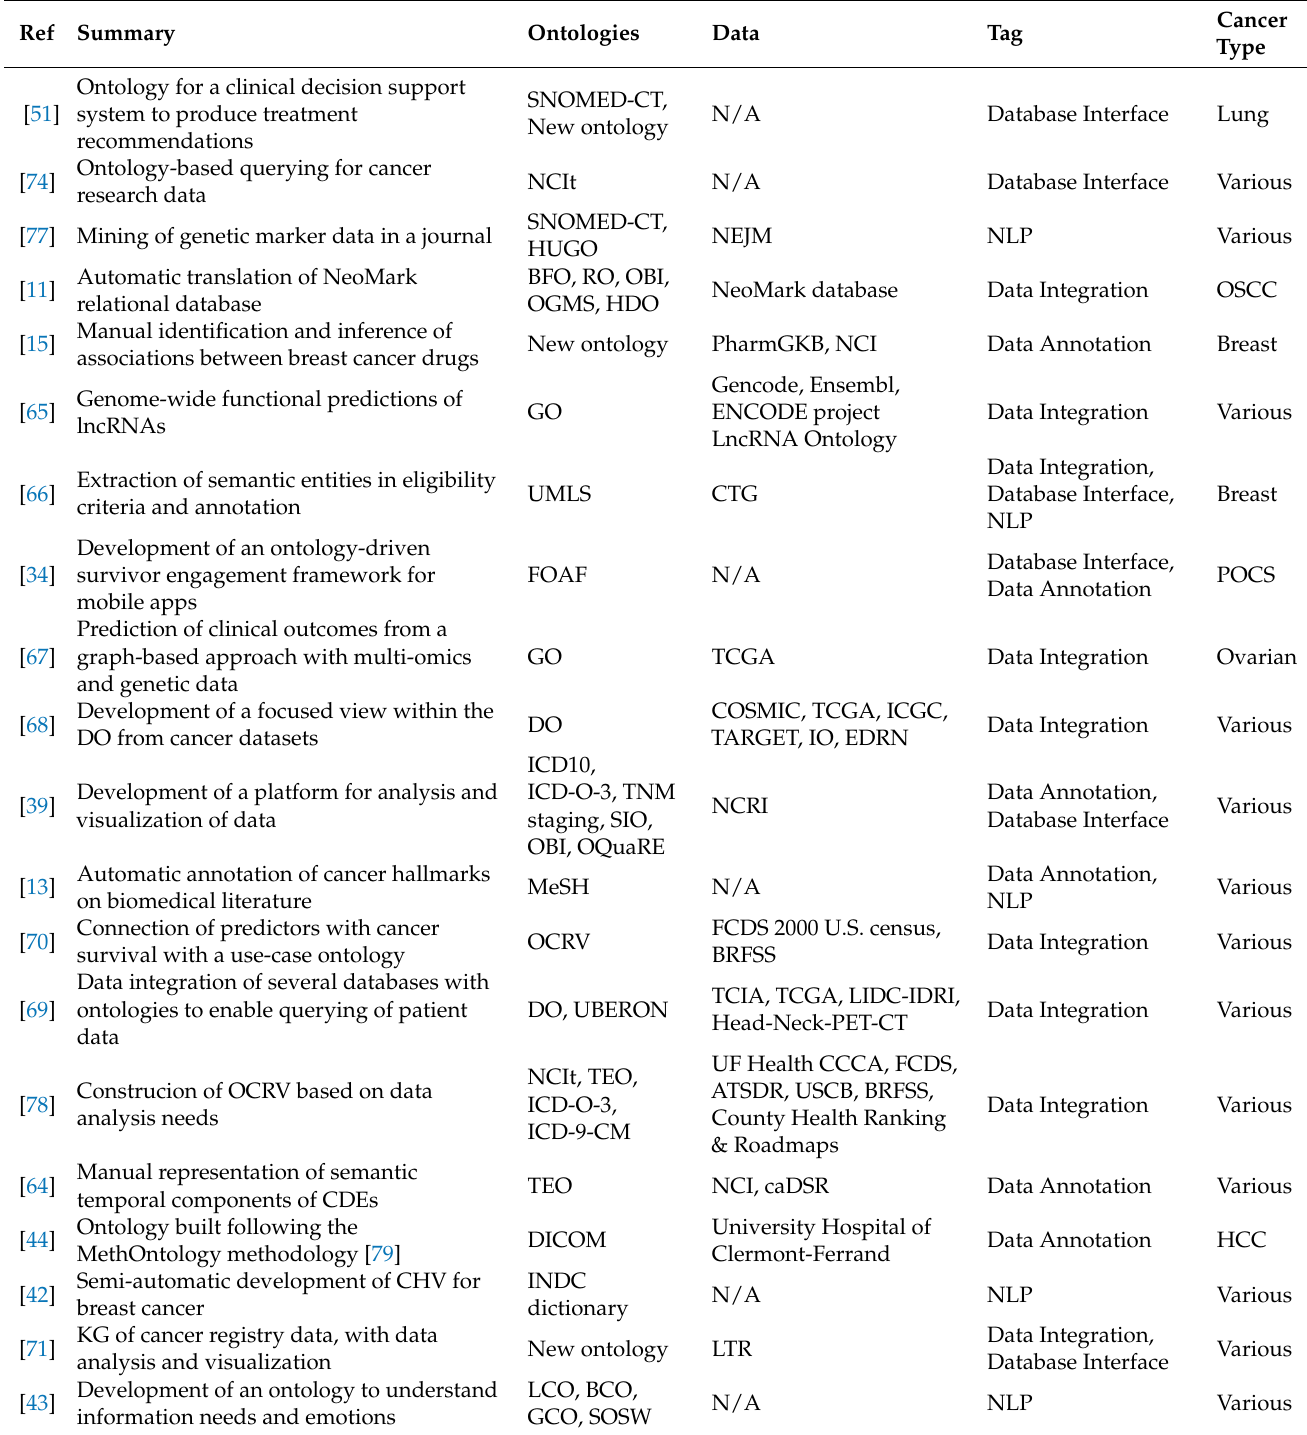
Table 2. Terminology-focused